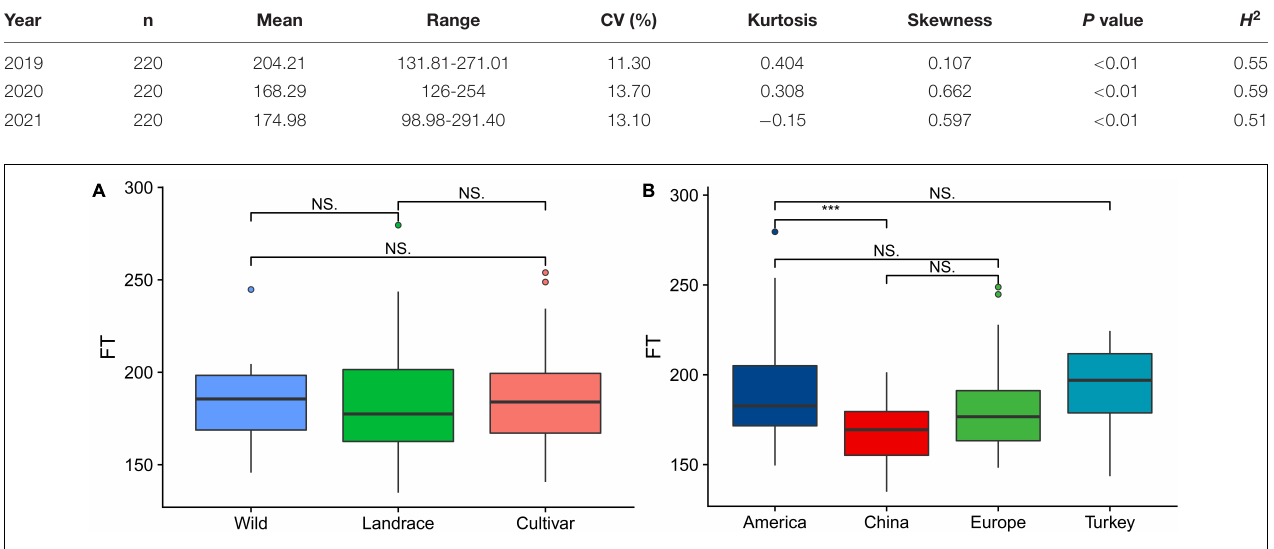
FIGURE 1 | Boxplots showing the variation in the flowering time evaluated in each association panel. (A) Boxplot of the flowering time of plants in the subgroups (wild, landrace, and cultivar groups) according to the breeding status. (B) Boxplot of the flowering time of plants in the subgroups (America, China, Europe, and Turkey) according to geographical origin. The different asterisks above the boxplots in (A,B) indicate significant differences at the P < 0.05 level according to Duncan’s multiple comparison test.